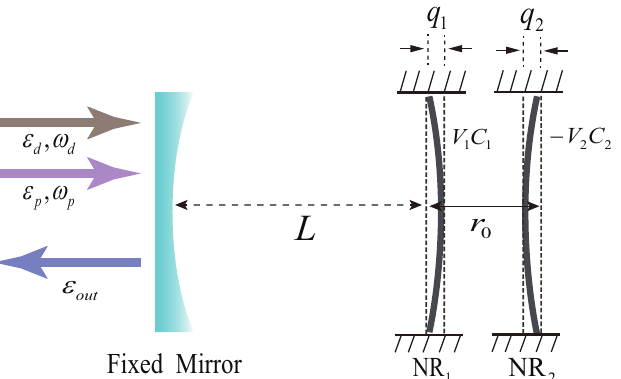
Figure 1. A schematic illustration of the system. It consists of a high-quality Fabry-Pérot cavity and two NRs, which are charged by the bias gate voltages V 1 and − V 2 . q 1 ( q 2 ) represents the small displacement of NR 1 (NR 2 ) from the equilibrium position, in which r 0 is the equilibrium distance between two NRs. The optomechanical cavity is driven by a strong driving field ε d and a weak probe field ε p , and the output field is denoted by ε out